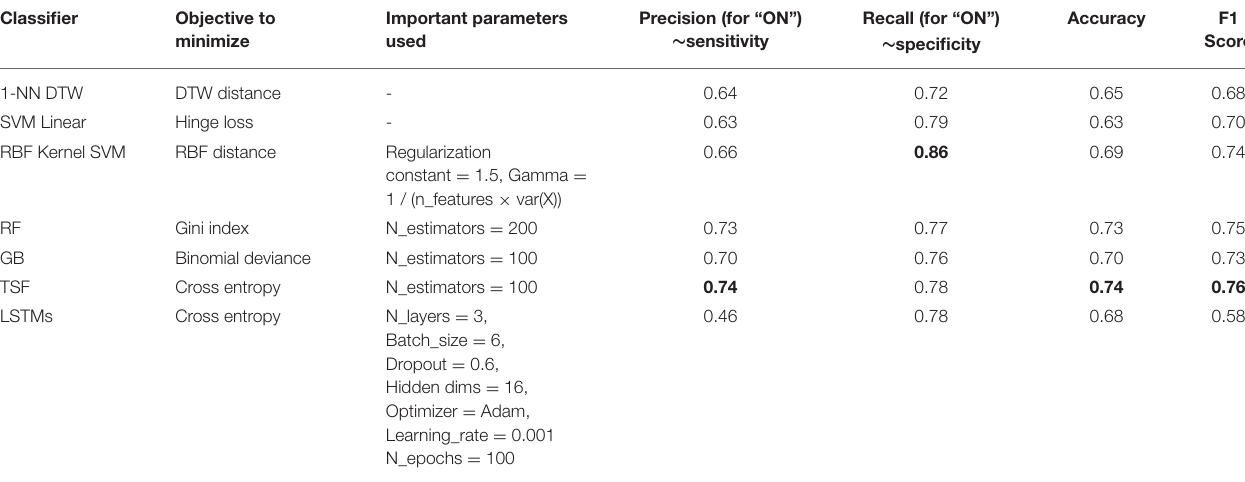
TABLE 3 | Classifier objectives parameters used in the best performing model on the testing set and the results from the testing set. Classifier